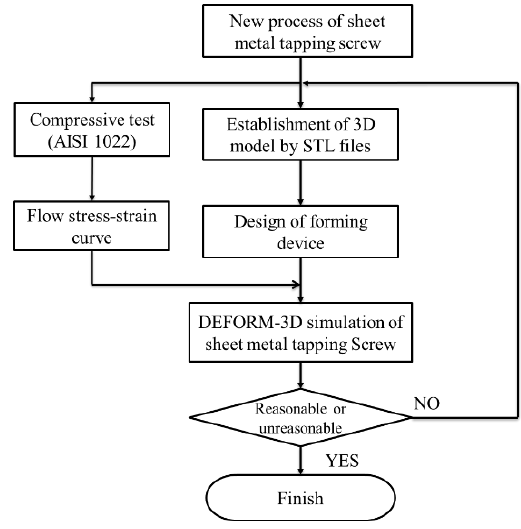
Figure 7. Research flow chart. Table 1. DEFORM simulation parameters.